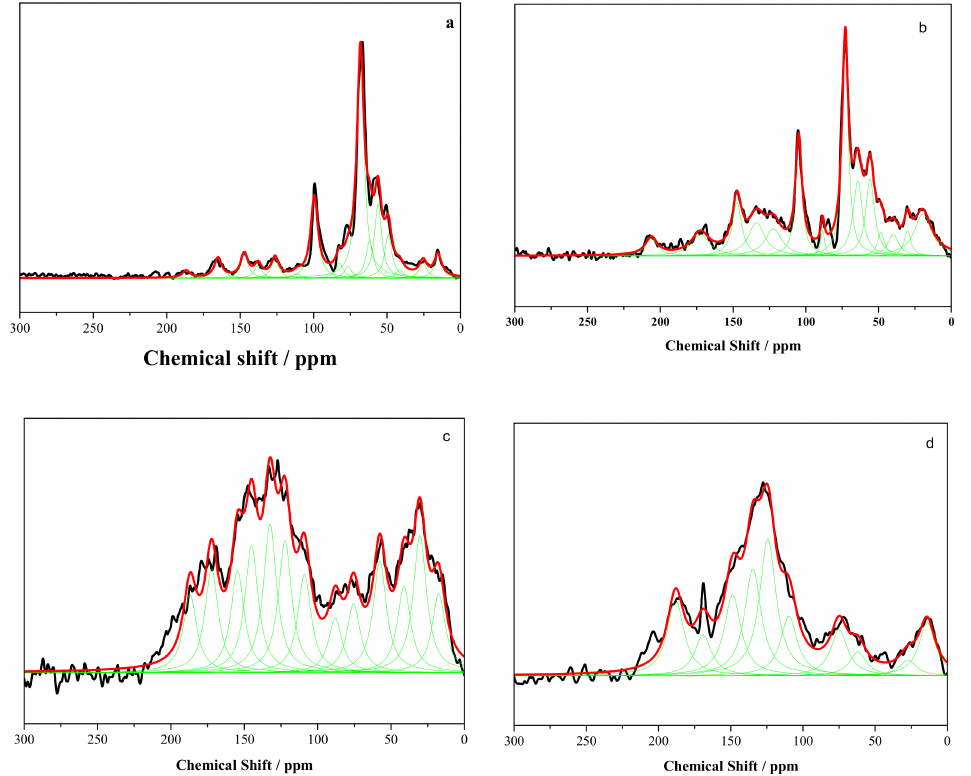
Figure 3. Fitting curves in 13 C-NMR spectra of raw and terrified cedar (( a )—cedar, ( b )—C-200, ( c )—C-250, ( d )—C-300). Green line: Fitting peak curve; Red line: Fitting curve; Black line: Raw